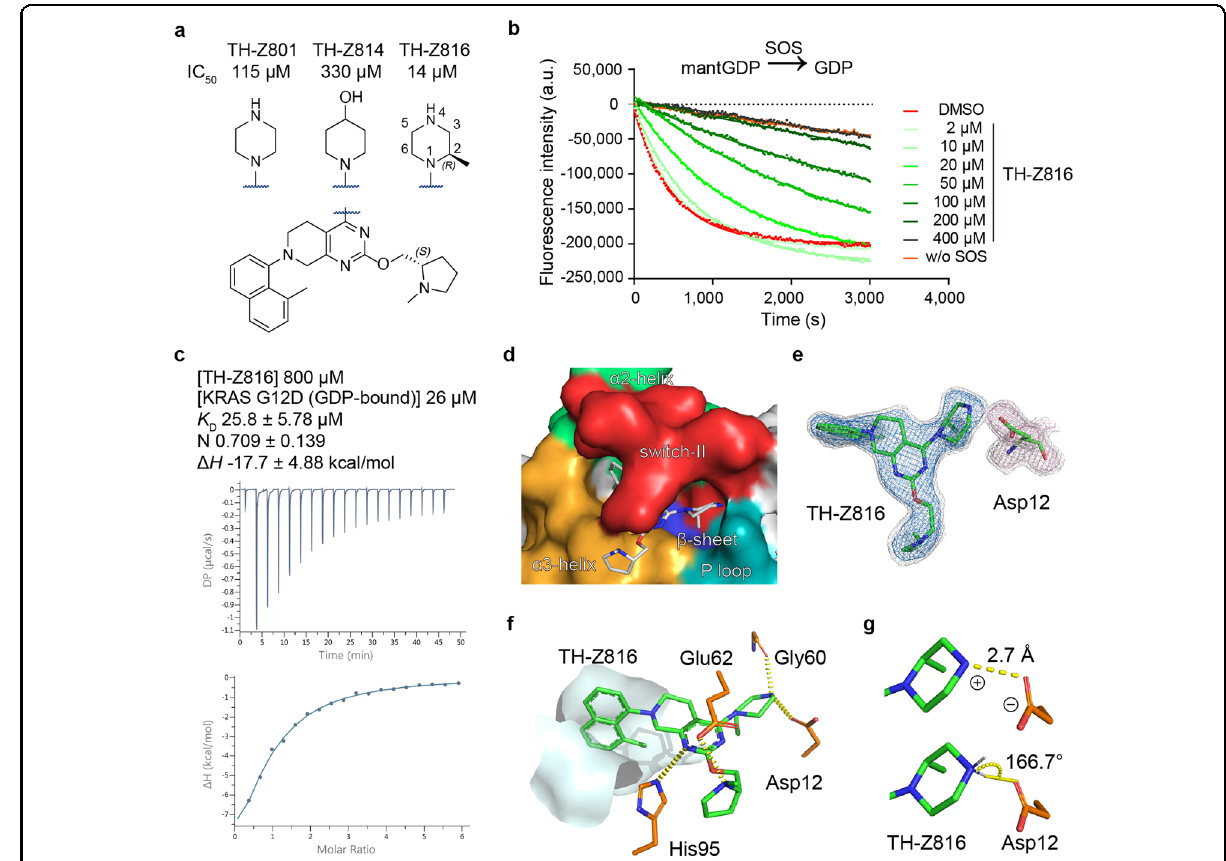
Fig. 1 A piperazine-focused strategy for targeting KRAS(G12D) via salt-bridge interaction. a Chemical structures of TH-Z801 and TH-Z816 with exposed piperazines, structure of TH-Z814 with non-amine moiety. b Inhibitory activities of TH-Z816 on KRAS(G12D) measured by SOS-catalyzed nucleotide exchange assay with GDP as the incoming nucleotide. c ITC assay of the TH-Z816 (800 μ M) and GDP-bound KRAS(G12D) (26 μ M). d Crystal structure (PDB ID: 7EW9) of KRAS(G12D) bound to TH-Z816 (white stick). The binding pocket is formed by the α 2-helix (green), switch-II (red), α 3-helix (orange), P-loop (teal), and the central β -sheet (blue) of KRAS(G12D). e Fo-Fc maps of TH-Z816 (blue mesh, 2.5 σ ; gray mesh, 1.5 σ ) and Asp12 (pink mesh, 2.5 σ ; gray mesh, 1.5 σ ). f Interactions between TH-Z816 (green) and surrounding residues (orange). The hydrophobic sub-pocket is shown as a surface diagram. g The ionic bond (upper panel) and hydrogen bond (lower panel) between piperazine and